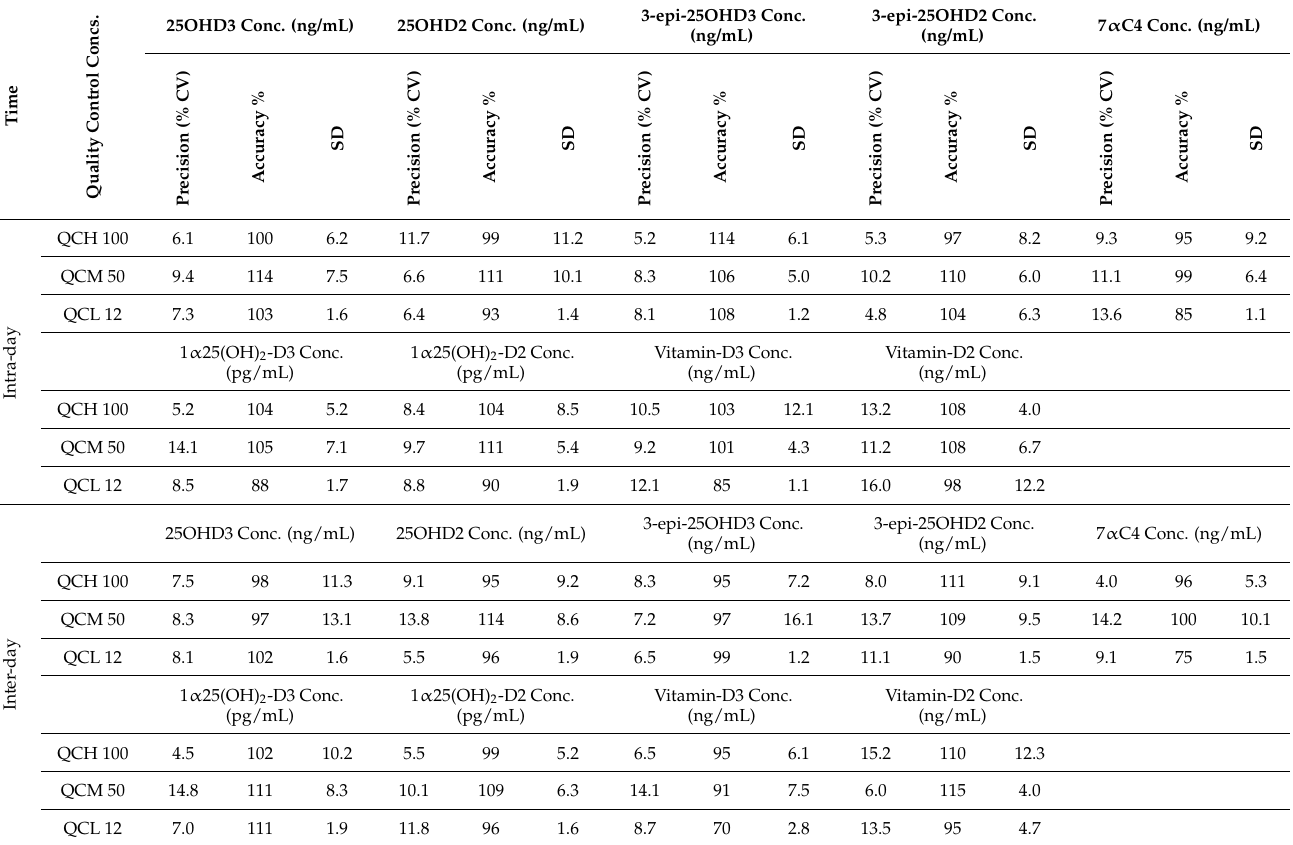
Table 1. Intraday–interday precision and accuracy of vitamin D metabolites and 7 α